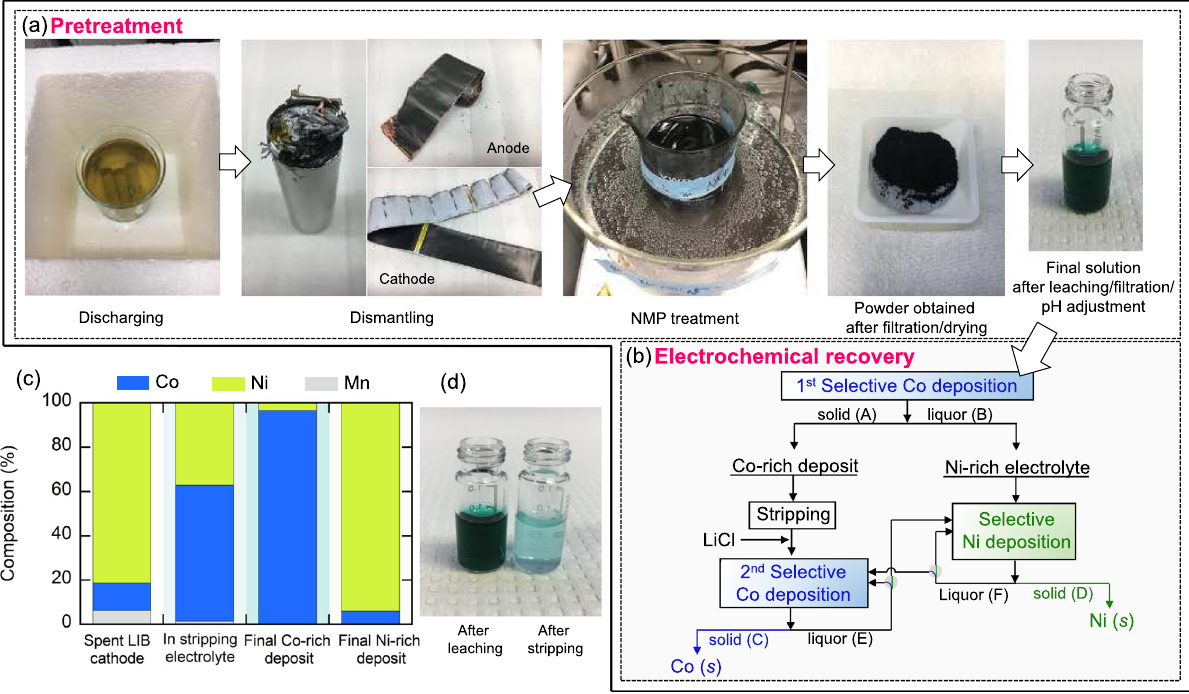
Fig. 5 Application of selective electrodeposition for potential use in battery recycling processes. a Pretreatment steps of spent LIBs: discharging, dismantling, NMP treatment, and leaching. See the “ Methods ” section for details. b A simpli fi ed schematic representation of the process envisioned in this work for the electrochemical recovery of cobalt and nickel. c Molar composition of liquid/solid hydrometallurgical streams: (i) spent NMC cathode, (ii) after selective cobalt electrodeposition followed by anodic stripping, (iii) fi nal Co-rich electrodeposit after second cobalt-selective electrodeposition, and (iv) fi nal Ni-rich electrodeposit after selective nickel electrodeposition. d Pictures of the liquid electrolytes: (i) after leaching and (ii) after a cycle